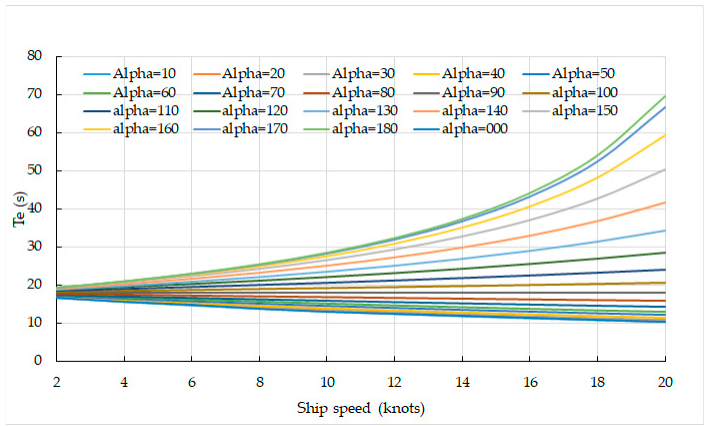
Figure 11. Te for di ff erent combinations of ship speeds and α angles, for a Tw = 18 s.